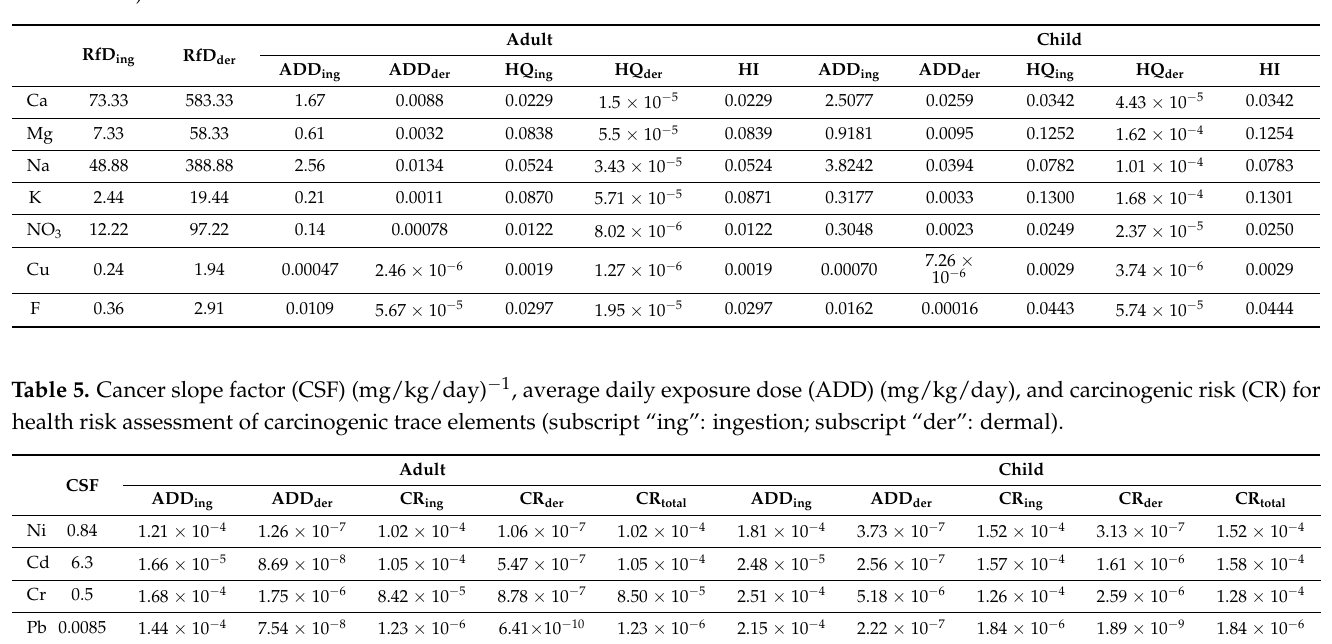
Table 4. Reference dose (RfD) (mg/kg/day), average daily exposure dose (ADD) (mg/kg/day), hazard quotient (HQ), and hazard index (HI) for health risk assessment of non-carcinogenic trace elements (subscript “ing”: ingestion; subscript “der”: dermal).